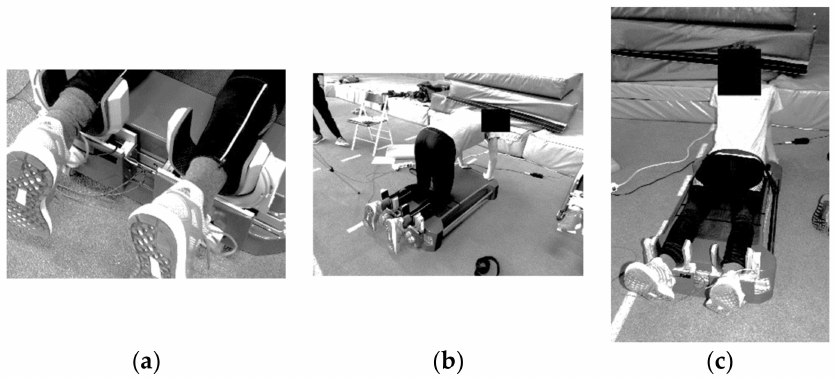
Figure 2. Isometric hip muscle testing. ( a ) Ankle position during hip external and internal rotation, ( b ) position during hip external and internal rotation and ( c ) hip adduction and